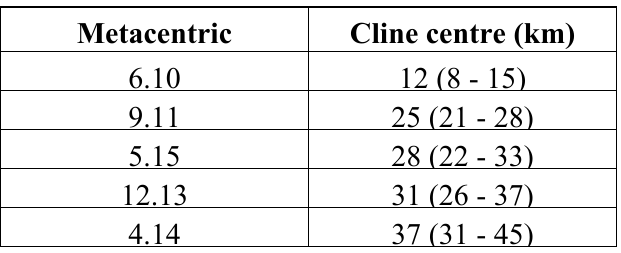
Table 1. The cline centres (with 95% confidence intervals) for five metacentrics in the Barcelona area showing staggered clines